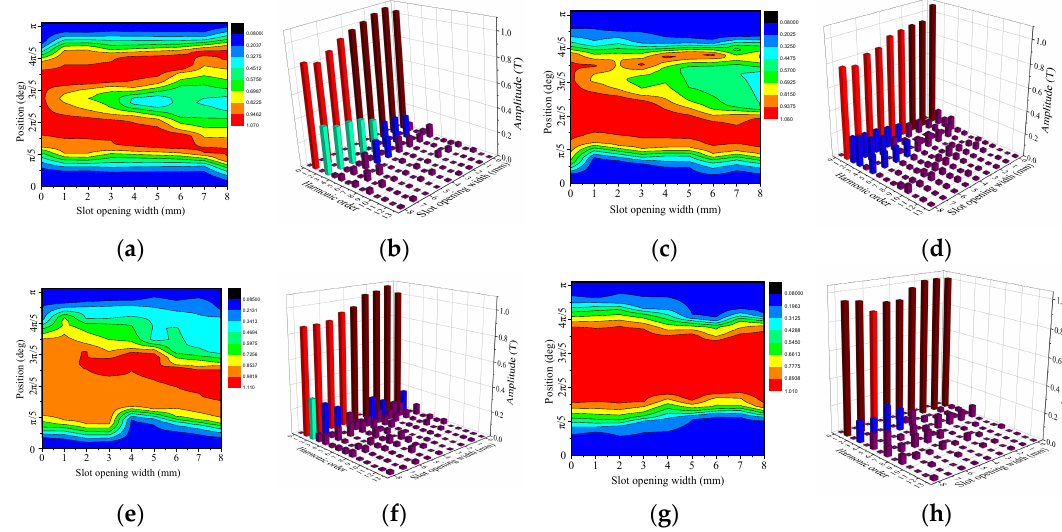
Figure 11. Air-gap magnetic field analysis of the DDPMM with 24 poles and 27 slots at different positions: ( a ) magnetic field distribution at position 1; ( b ) harmonics at position 1; ( c ) magnetic field distribution at position 2; ( d ) harmonics at position 2; ( e ) magnetic field distribution at position 3; ( f ) harmonics at position 3; ( g ) magnetic field distribution at position 4; ( h ) harmonics at position 4.